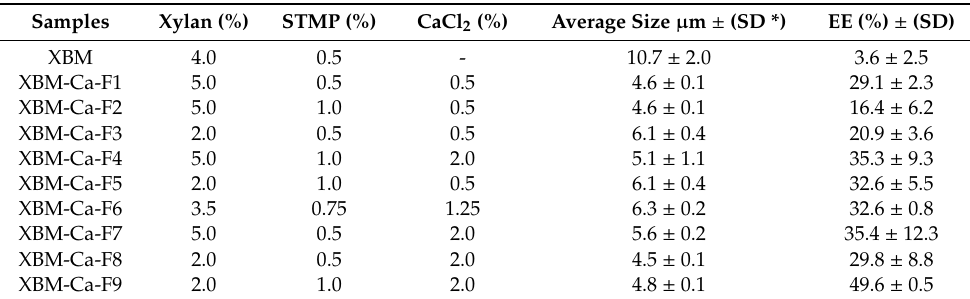
Table 1. Experimental results of average diameter size and EE% of XBM and all XBM-Ca prepared based on the 2 3 experimental